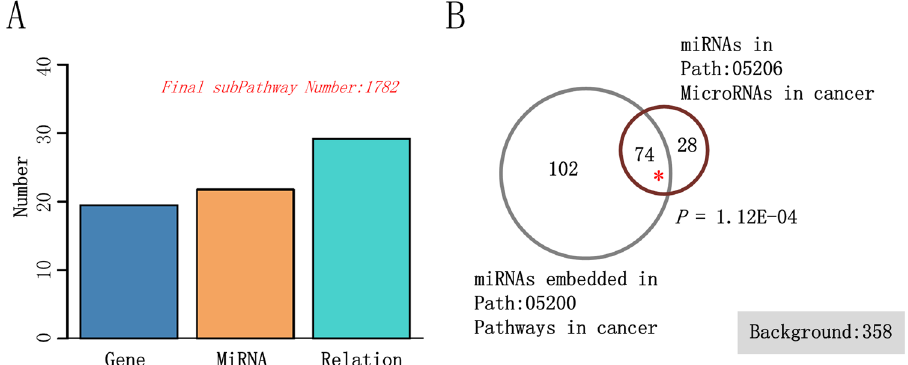
Figure 1. The analyses of reconstructed subpathway graphs. ( A ) The average number of gene nodes, miRNA nodes, and miRNA–gene interactions within each subpathway graph. ( B ) A comparison between the reconstructed pathway graph (Path 05200) and the original pathway graph (Path